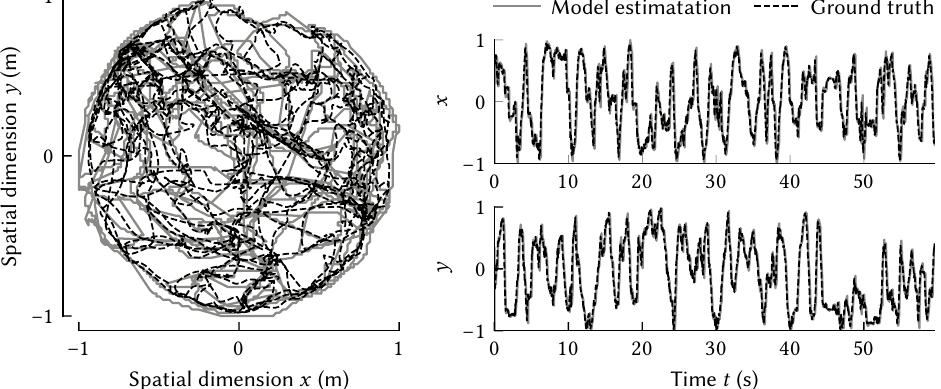
Figure 12. The path integration model results on a 60 s long 2D path (a rat’s trajectory running in a cylinder with a diameter of 180 cm; obtained from [51]). The grey line is the ground truth. As input the model received a initial position and the velocity along the path (computed via finite differences). The output of the model was a position estimate, in the form of an SSP, over time. The 2D path estimate plotted as a black dashed line was decoded from the raw SSP